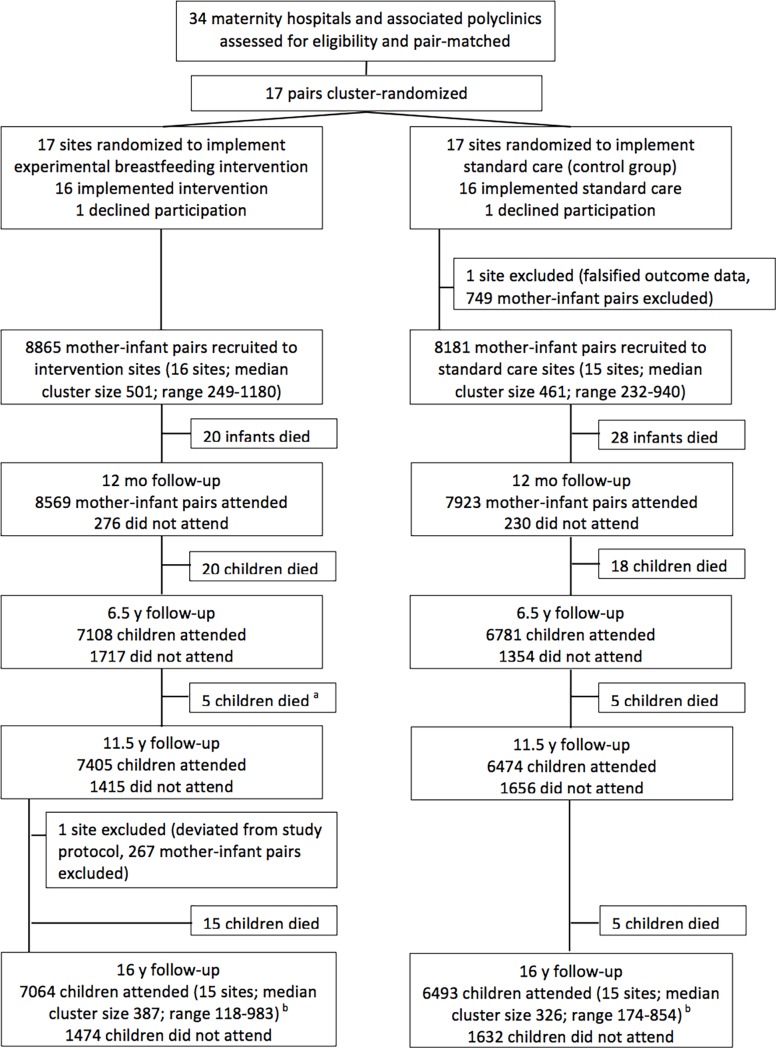
Flow diagram of clusters and participants of PROBIT recruitment follow-up phases at 12 mo, 6.5 y, 11.5 y, and 16 y.a: During the 11.5-y follow-up, 6 deaths were reported in the intervention arm. Data-checking during the 16-y follow-up found one of these children had been incorrectly reported as deceased and data were amended. b: Of the 13,557 seen at the 16-y follow-up, 12,072 were seen at both 11.5-y and 16-y follow-ups, 274 were not seen at either 6.5-y or 11.5-y follow-ups, 449 were seen at 6.5 y but not seen at 11.5 y, and 762 were seen at 11.5 y but not seen at 6.5 y. Of the 3,489 children randomized but not followed up at 16 y, 267 attended the excluded site, 116 died after randomization, 2,674 were lost to follow-up, and 432 were unable or unwilling to come for their clinic visit.